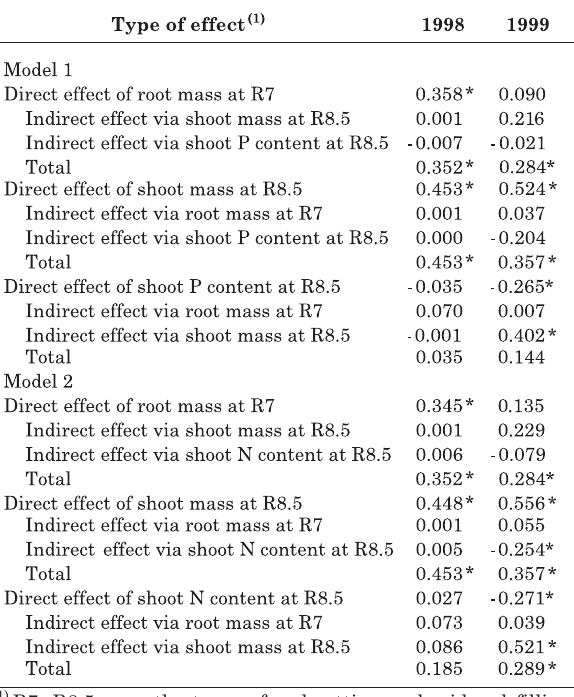
Table 5. Path coefficient analysis of the effects of biomass traits on grain yield of common bean cultivars grown in two field experiments (1998 and 1999); analysis performed with standardized